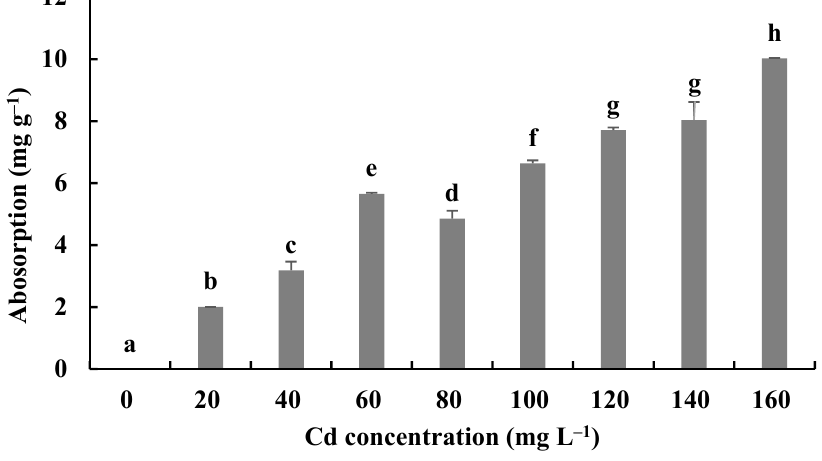
Figure 7. Cd 2+ absorption by H. chrysospermus. Different letters indicated significant difference ( p < 0.05).